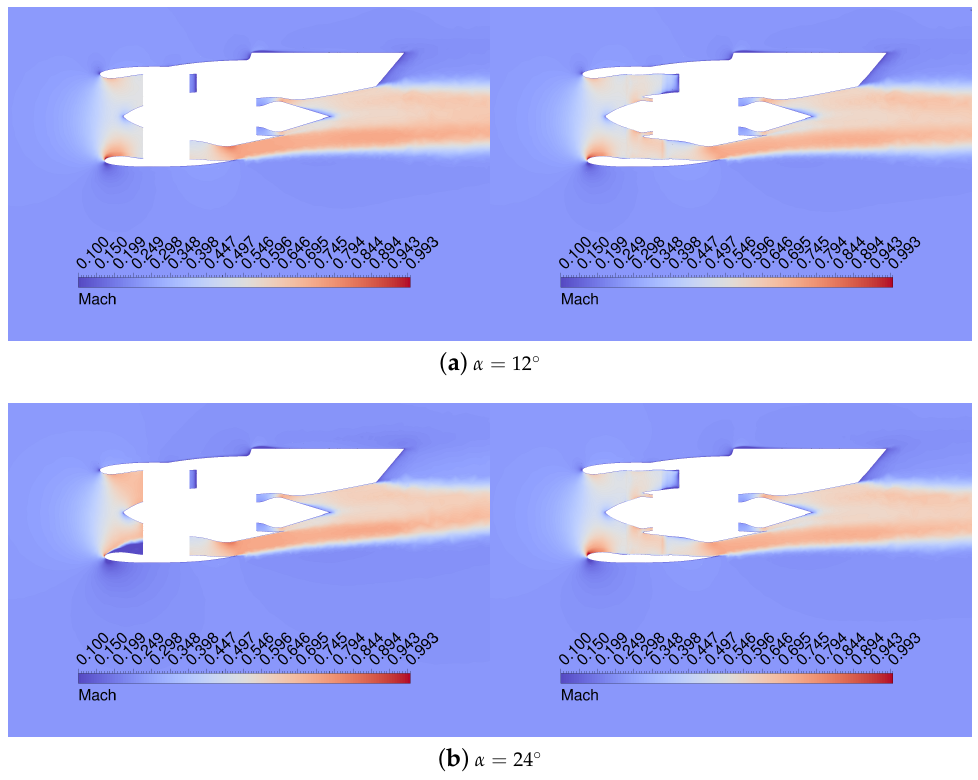
Figure 21. Mach number distribution for isolated nacelle case at M = 0.25 and two angles of attack with boundary conditions ( left ) and body force ( right ) engine